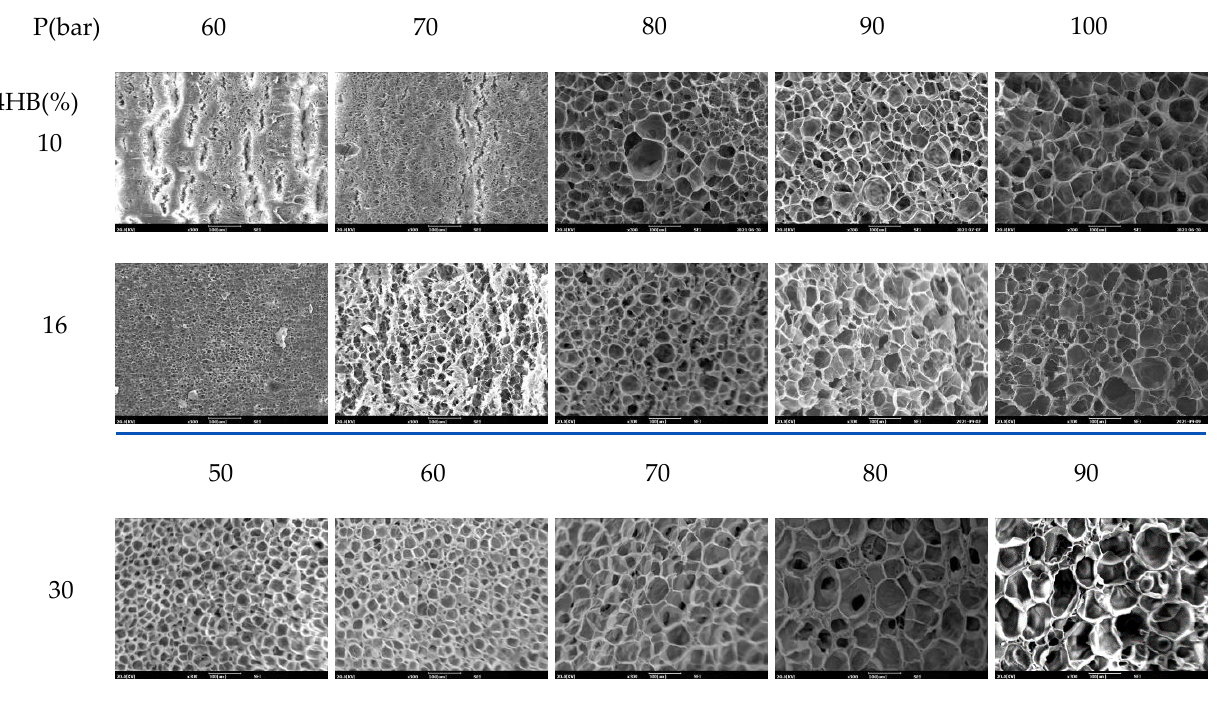
Figure 7. SEM micrographs of P(3HB- co -4HB) foamed at various foaming pressure. Foaming temperatures of P(3HB- co -10% 4HB), P(3HB- co -16% 4HB), and P(3HB- co -30% 4HB) are 130 °C, 100 °C, 50 °C, respectively.